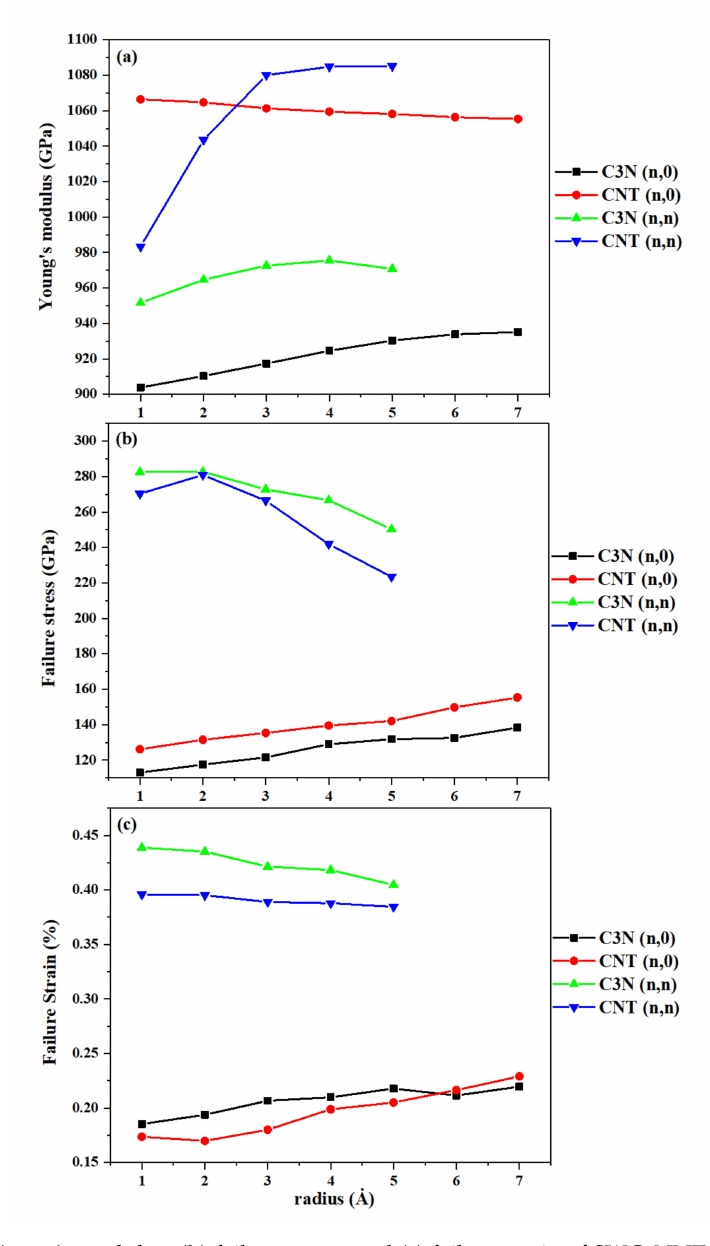
Figure 4. ( a ) Young’s modulus, ( b ) failure stress, and ( c ) failure strain of SWC 3 NNTs and SWCNTs under uniaxial tensile tests at 300 K, as a function of their